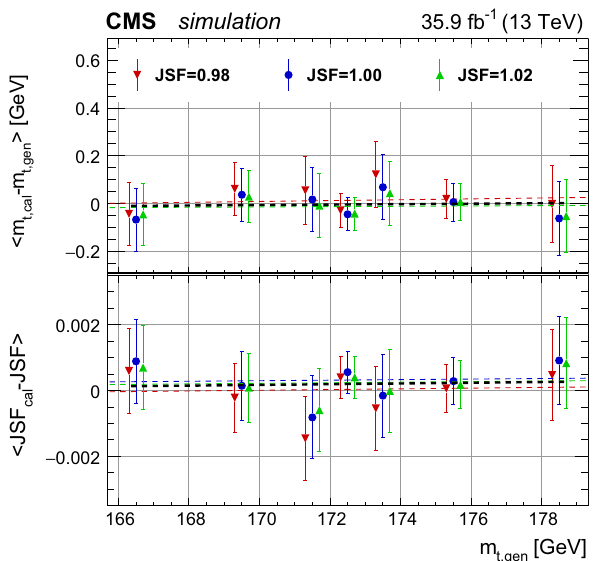
Fig. 5 Likelihood contours for − 2 Δ ln L = 2 . 3, corresponding to the 68% confidence level, in the m t -JSF plane (upper panel) and the like- lihood profiles for the top quark mass (lower panel), where the level corresponding to one standard deviation ( σ ) is indicated. The hybrid measurement results for the all-jets and lepton+jets channels, as well as for the combination, are